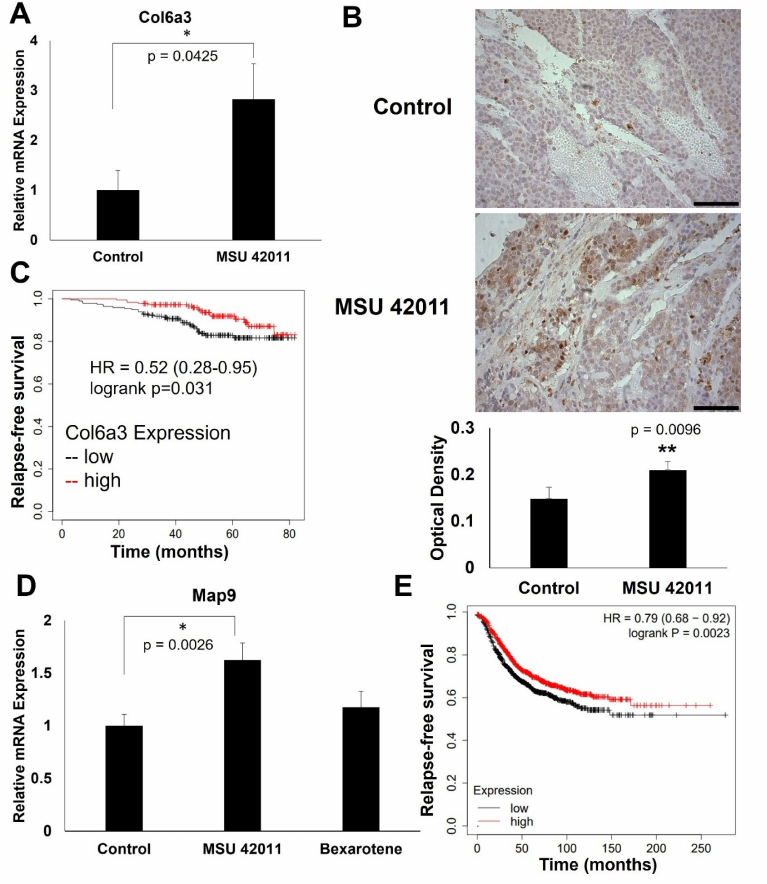
Figure 5. MSU-42011 increases Col6a3 and Map9 expression in mouse mammary tumors. Tumors treated with MSU-42011 (100 mg/kg diet) or control were harvested and flash-frozen. Tumors were homogenized and RNA extracted. ( A , D ) mRNA expression was detected by qPCR. N = 5 mice/group. Error bars represent standard error. * p < 0.05; ** p < 0.01 ( B ). Immunohistochemical staining for Col6a3, representative of four mice per group and quantified using ImageJ. Scale bar = 60 µ m, 40 × magnification ( C , E ) Kmplot survival curves correlate expression of Col6a3 ( C ) with survival in HER2+ breast cancer patients (n = 379; 183 high, 196 low) and Map9 ( E ) with survival in breast cancer patients (n = 2032; 1015 high, 1017